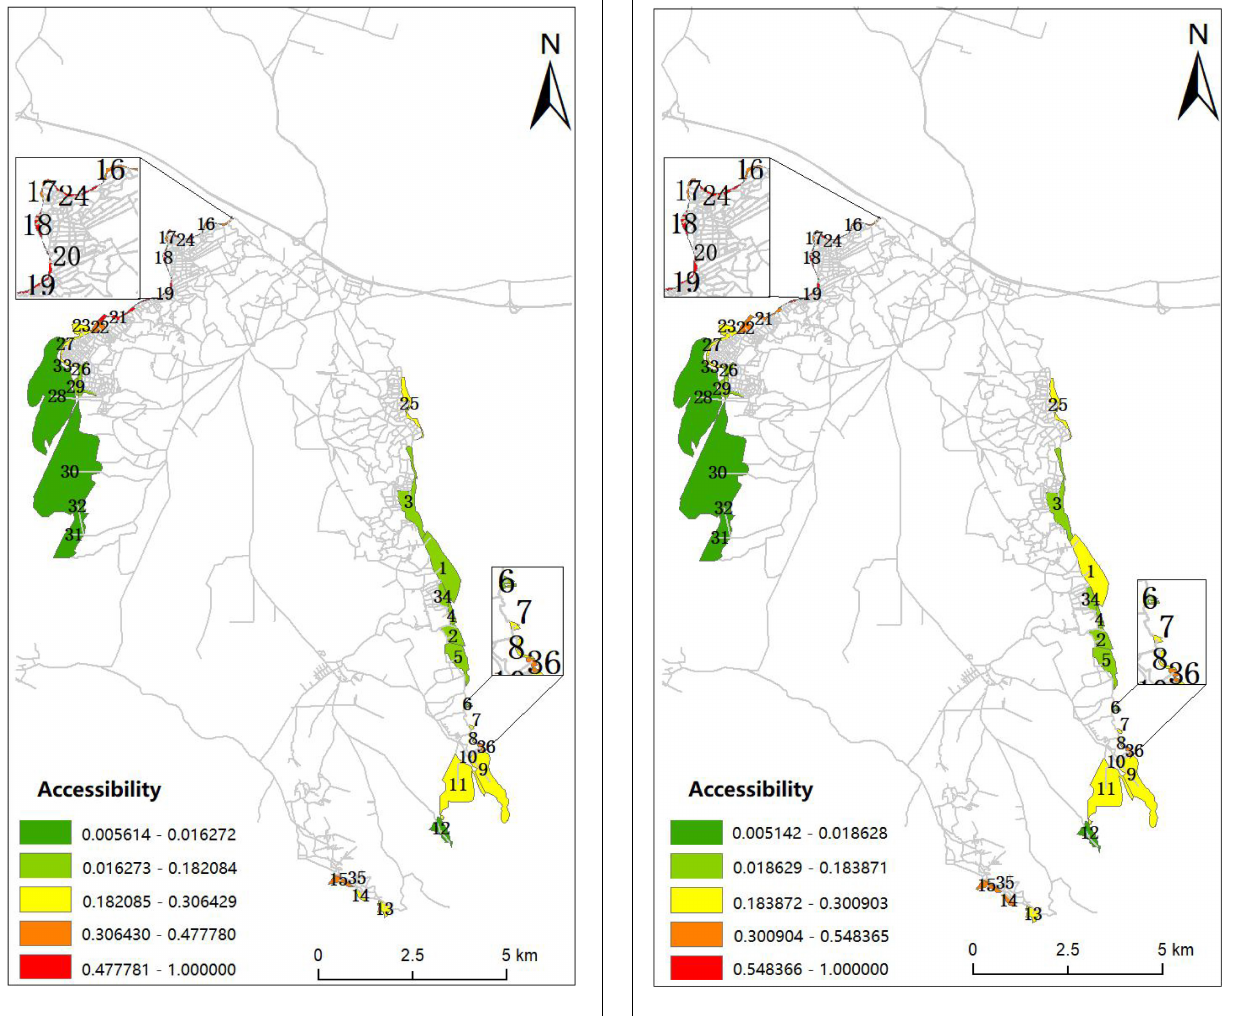
FIGURE 5 | Accessibility calculated by the frequency of visits. FIGURE 6 | Accessibility of different behaviors of visits to